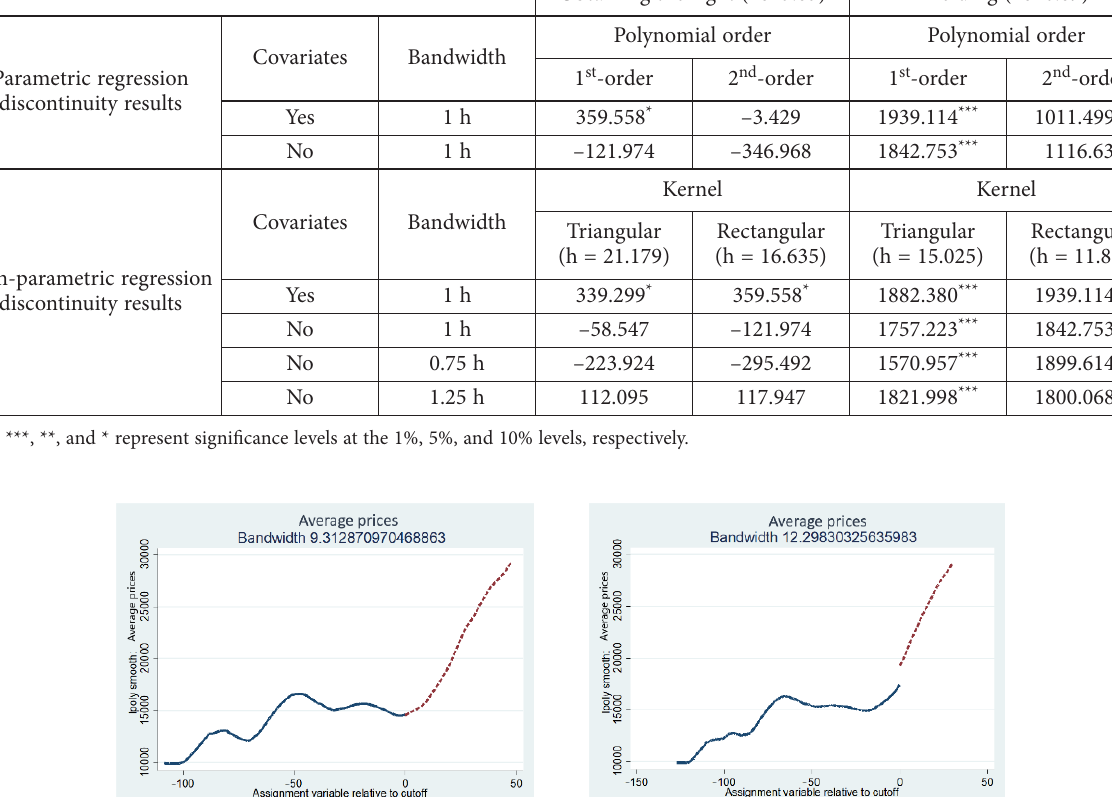
Table 5. Impact of the G20 summit using parametric and non-parametric models Obtaining the right (2015.03) Holding (2016.09)